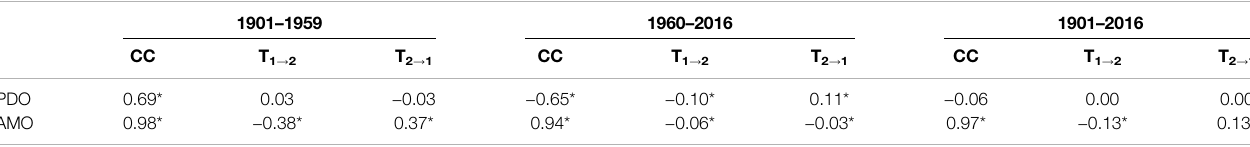
TABLE 2 | Correlation coef fi cients and information fl ow between PDO and MTDI on the interdecadal scale and between AMO and MTDI on the multi-decadal scale (* Represents passing the signi fi cance test with a 95% con fi dence level). 1901 –